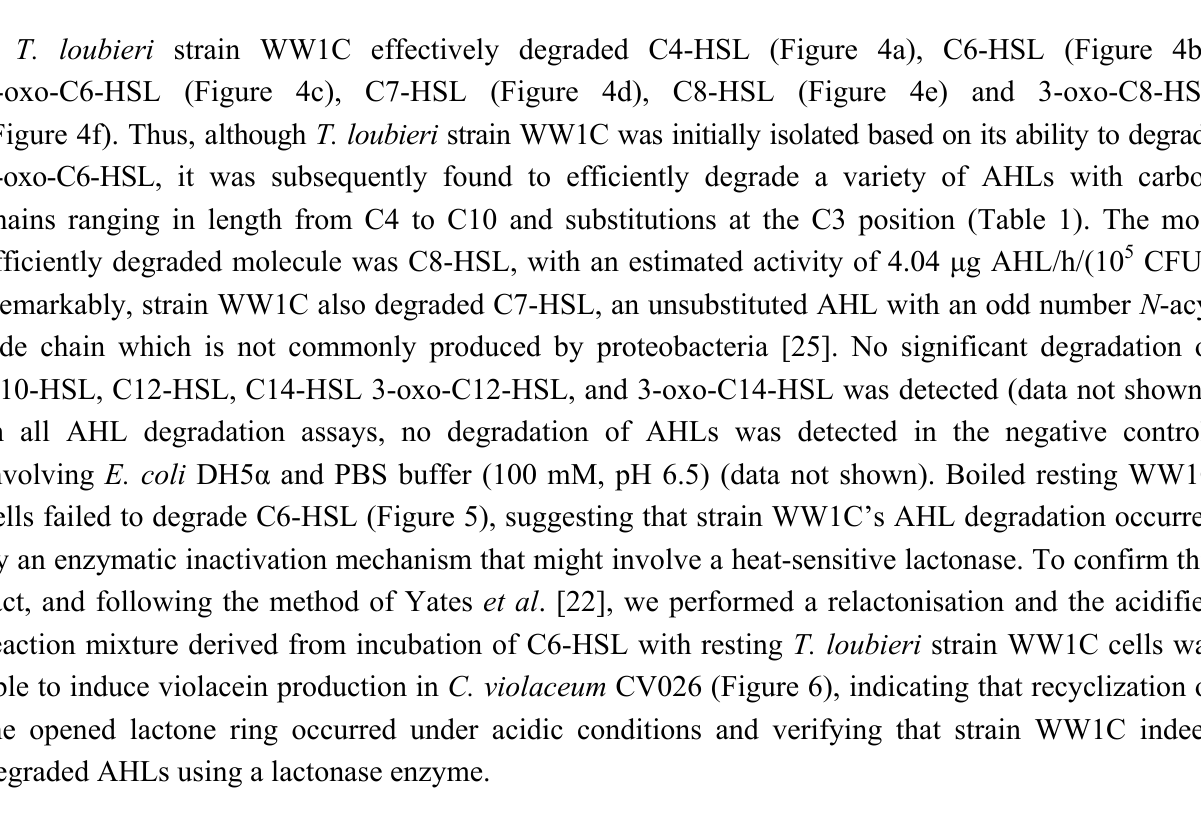
Figure 4. RRLC analysis of AHLs degradation after 0-, 6-, 12-, 18-, and 24-h incubation with T. loubieri strain WW1C.Degradation of ( a ) C4-HSL; ( b ) C6-HSL; ( c ) 3-oxo-C6-HSL; ( d ) C7-HSL; ( e) C8-HSL and ( f ) 3-oxo-C8-HSL by T. loubieri strain WW1C